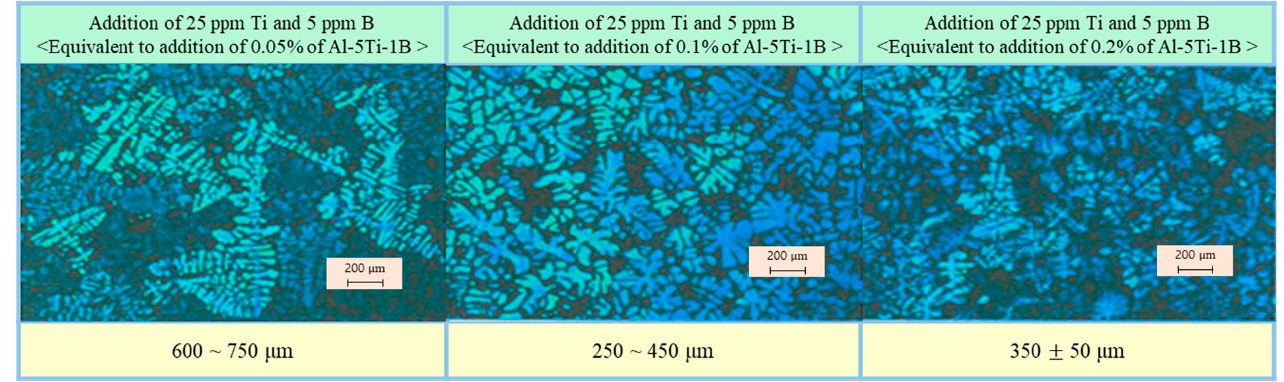
Figure 9. Comparison of the grain sizes of AC4CH alloy with different amounts of Al-5Ti-1B master alloy.